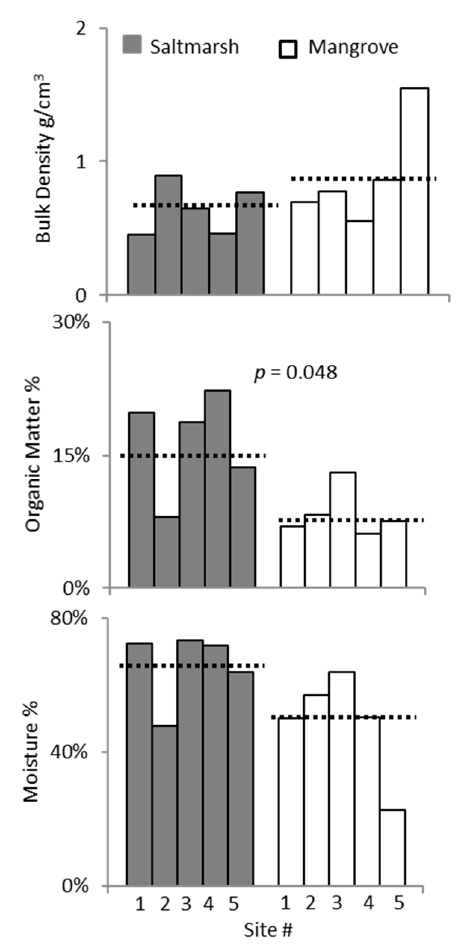
Figure 7. Survey of soil properties across saltmarsh (dark grey) and mangrove (white) sites along the ecotone. Each bar represents an individual site in each habitat, with site 5 representing the experimental site. Dashed lines represent average of all sites. Significant results are displayed in the inset panel. Data are shown as the mean ± SEM for five replicate sites.